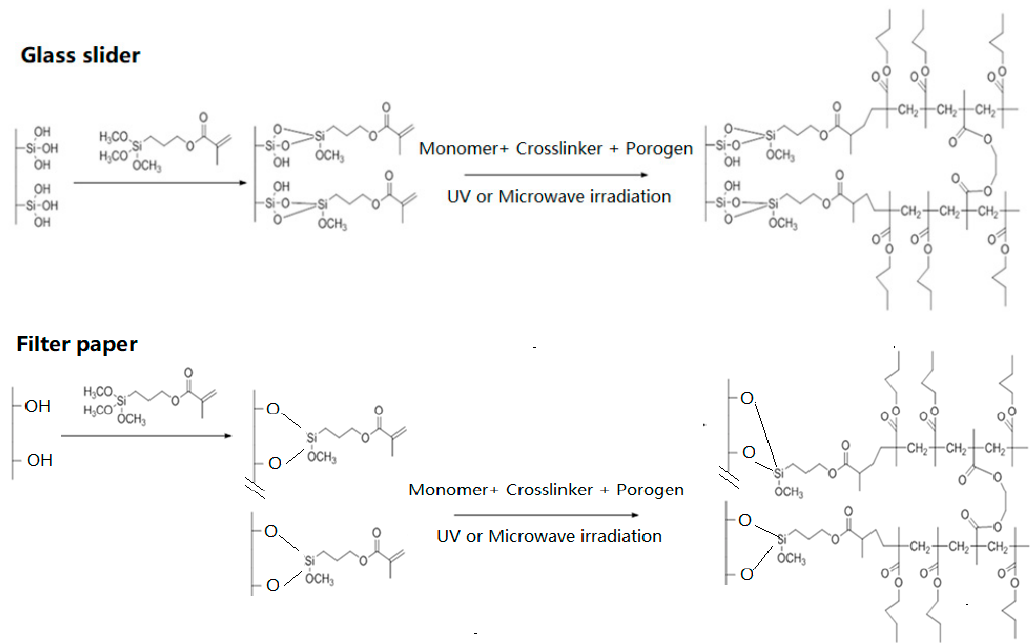
Scheme 1. Illustration of the fabrication procedures and relative mechanism on the glass slide and filter paper.